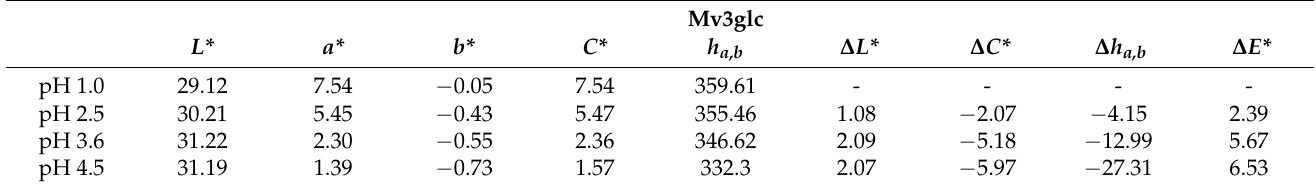
Table 1. Color coordinates of Mv3glc, vitisin A, Me-py, and oxovitisin A at different pH values.